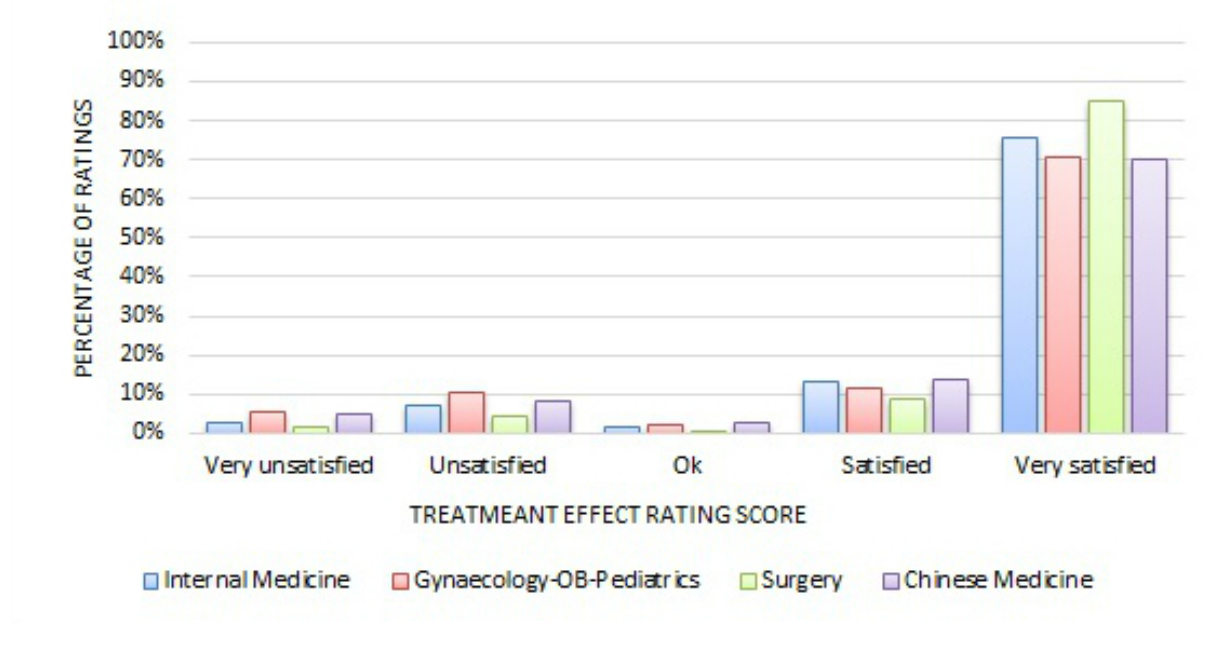
Figure 4. Distribution of bedside manner ratings across four major specialty